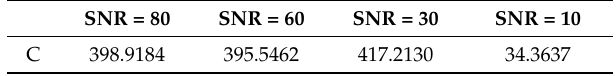
Table 5. The inversion results of different SNRs by DW-DIAL (unit: ppm).